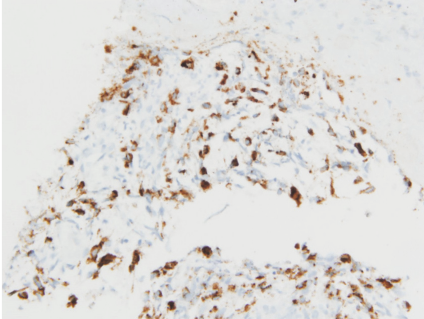
Figure 3: Immunohistochemistry from biopsy positive for HMB-45 consistent with